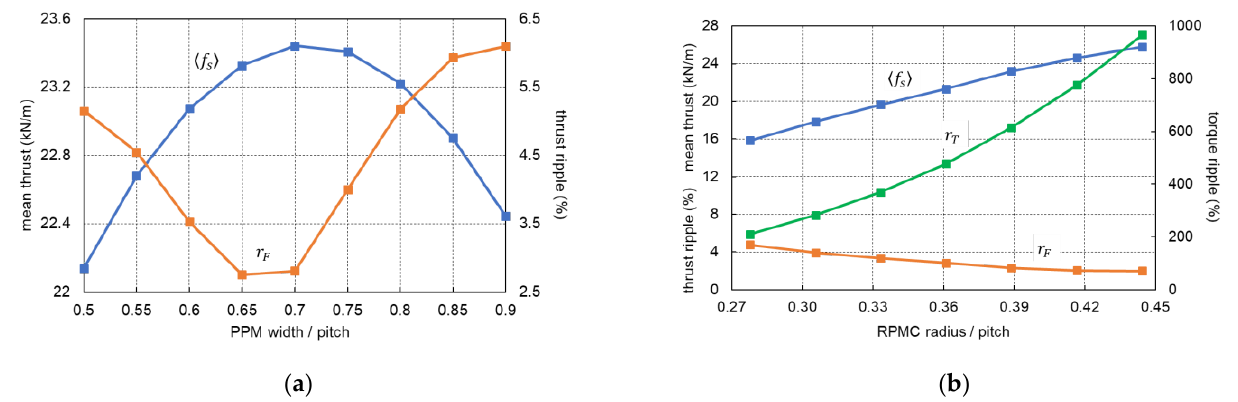
Figure 3. ( a ) pu depth mean value (cid:104) f s (cid:105) and ripple r F as functions of the ratio w p / τ p ( r c = 70 mm); ( b ) pu depth mean value (cid:104) f s (cid:105) and ripples r F , r T as functions of the ratio r c / τ c ( w p = 25 mm).